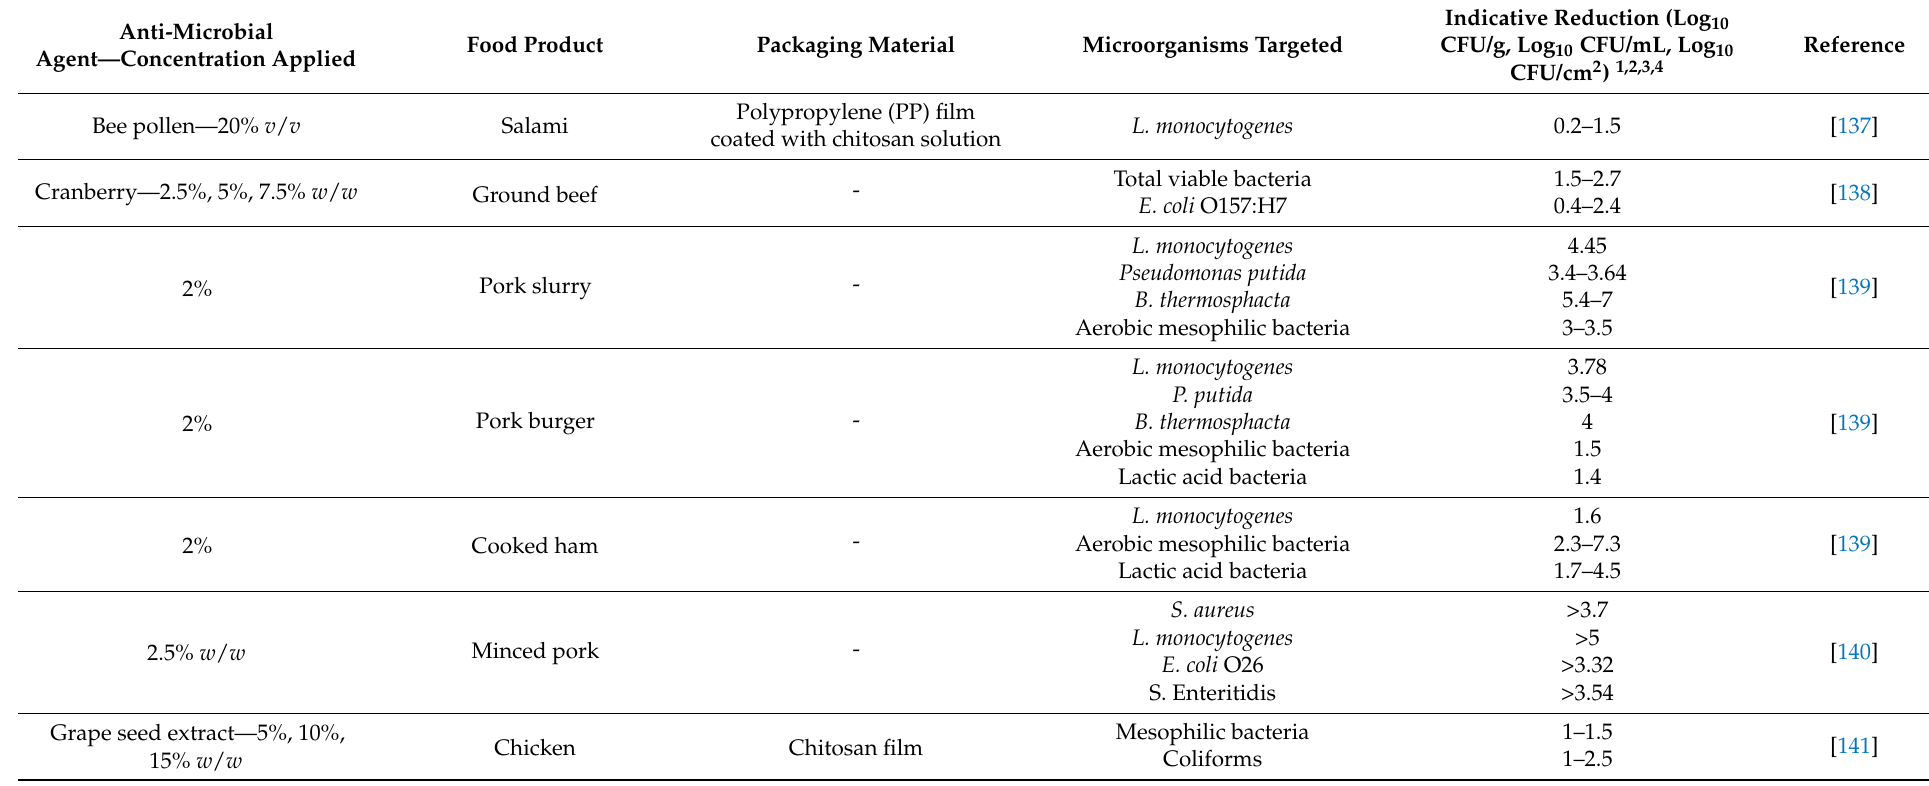
Table 3. Overview of studies testing the efficacy of flavonoid anti-microbial agents when added to meat products or incorporated into packaging materials.